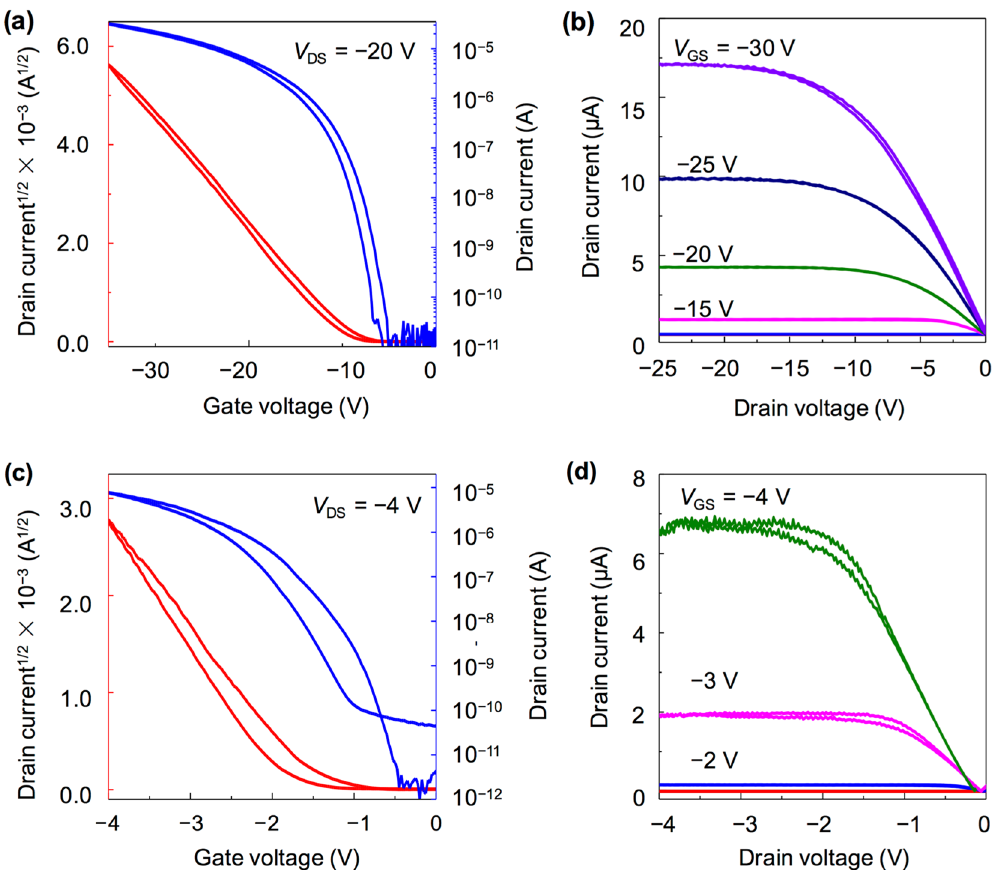
Figure 5. Electrical characteristics of the C 8 -BTBT-based OFETs on SiO 2 /Si and HfO 2 /Si. ( a ) Transfer characteristics at a drain voltage of − 20 V. ( b ) Output characteristics at different gate voltages of a device using SiO 2 . ( c ) Transfer characteristics at a drain voltage of − 4 V. ( d ) Output characteristics at different gate voltages of a device using